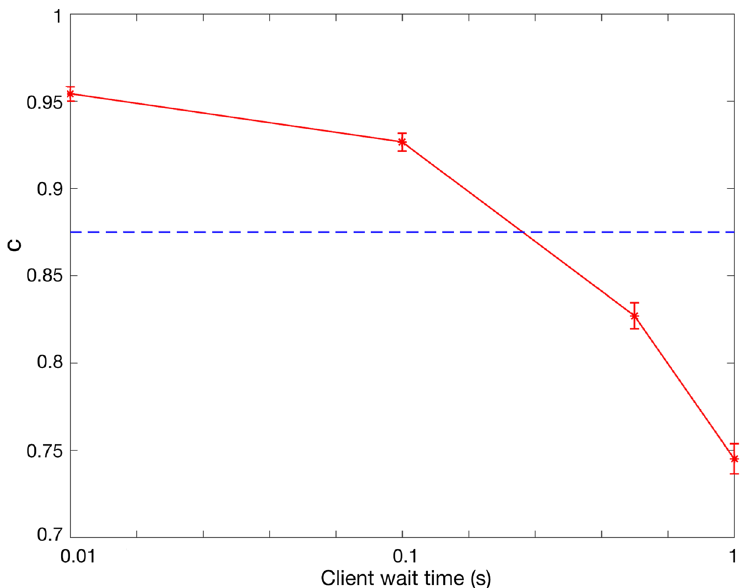
Figure 1. c versus client wait time, T . The blue dashed line shows the security threshold